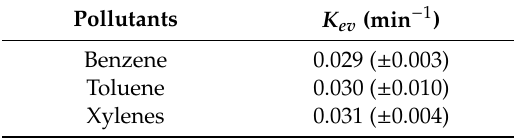
Figure 4. Time variation of the normalized concentration of BTX in the evaporation experiment. Table 3. Values of the evaporation kinetic constants determined by the evaporation